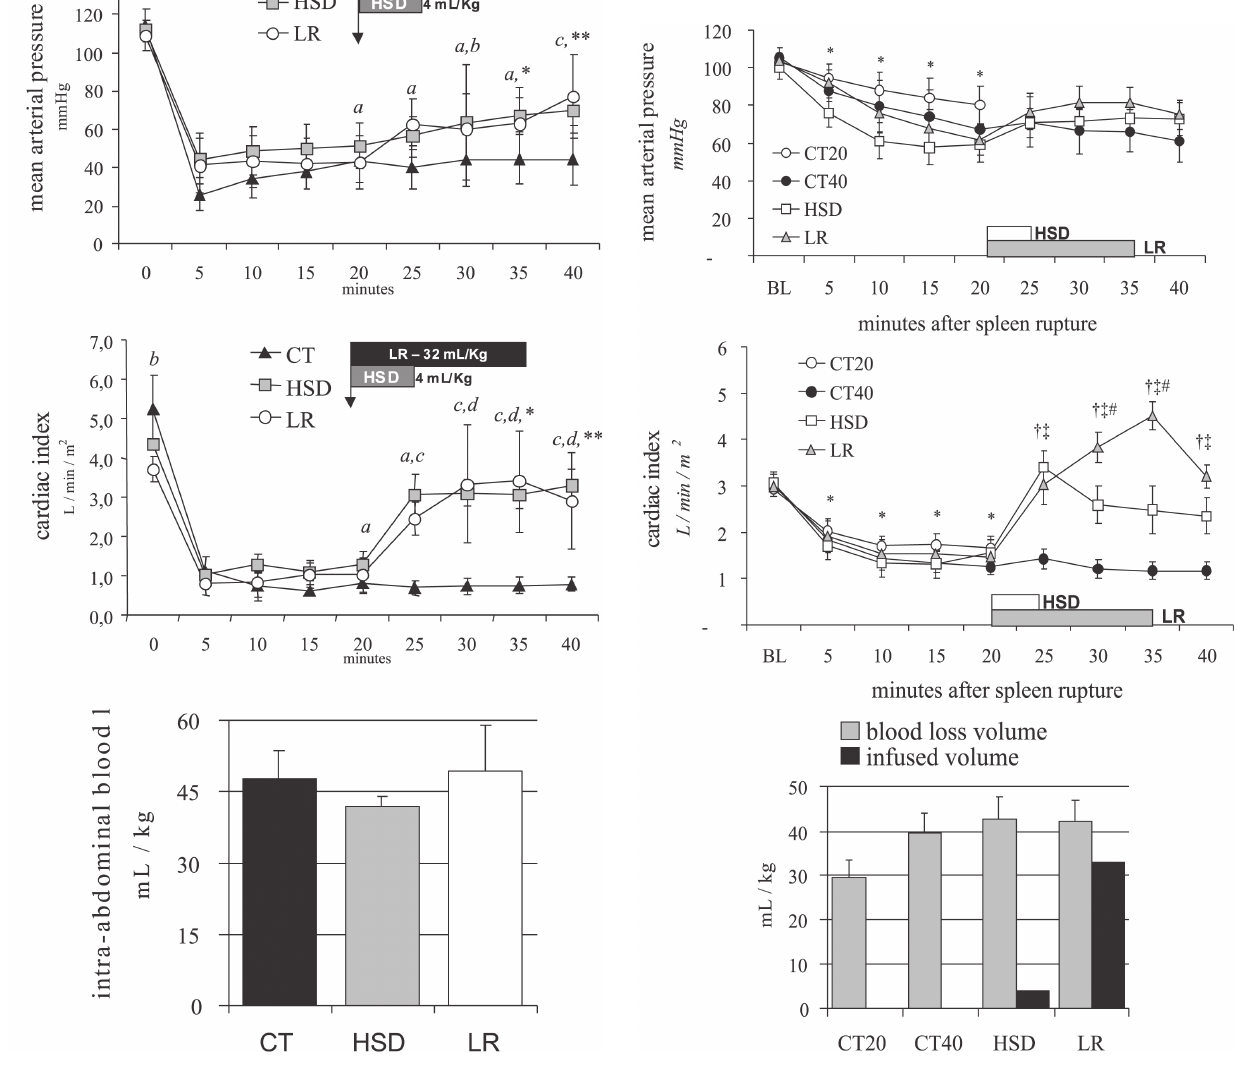
Figure 4 - Mean arterial pressure, cardiac index and blood volume loss during 40 minutes of uncontrolled intra-abdominal hemorrhage from an iliac artery tear for the CT group (no fluids), HSD group (4 mL/kg over 5 min), and the LR group (32 mL/kg over 15 min). Adapted from Bruscagin et al, 2002. 89